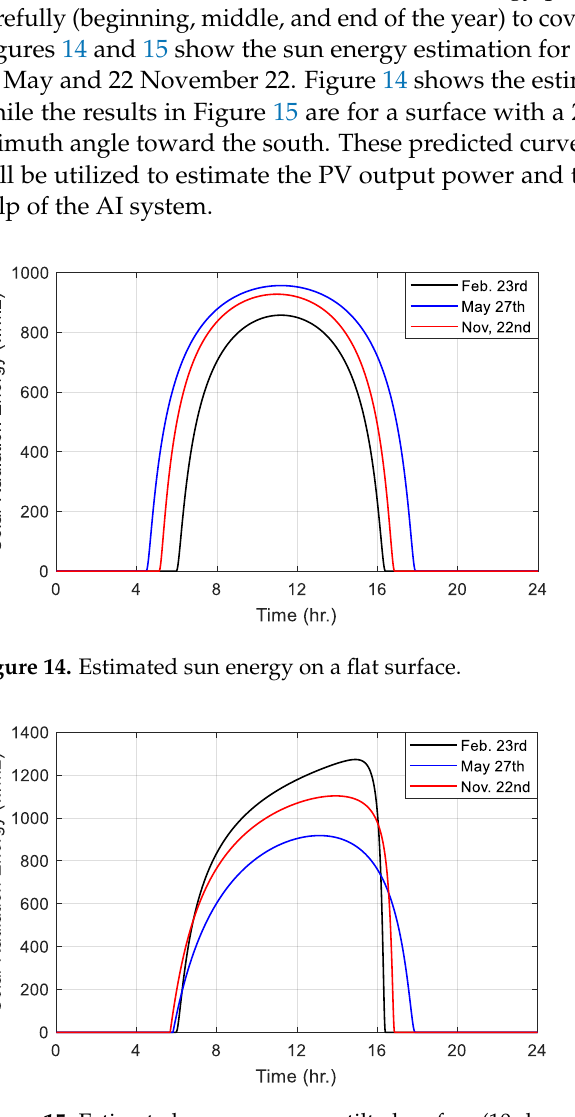
Figure 15. Estimated sun energy on a tilted surface (10-degree tilt angle).